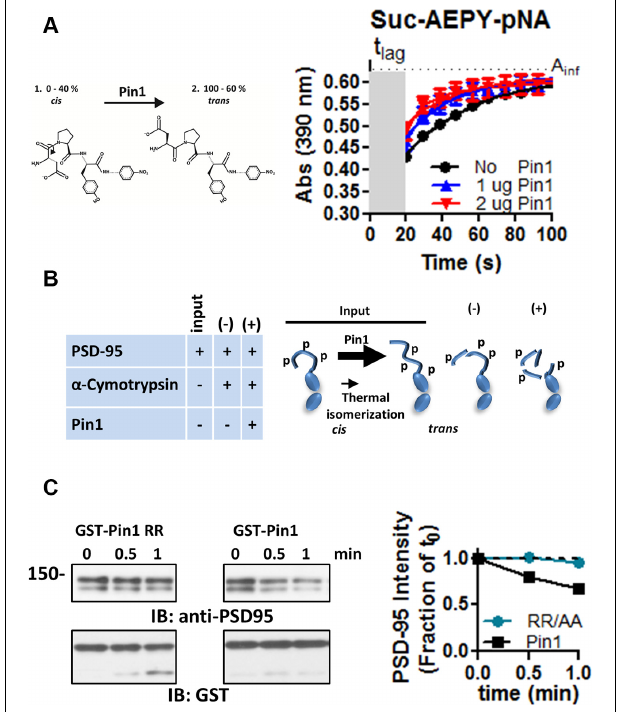
FIGURE 3 | Pin1 isomerizes full-length PSD-95. (A) A cis-trans isomerization scheme mediated by Pin1 on the succinyl-AEPY-p-nitronilide peptide. For representation, only EPY-p-nitronilide is shown. The predicted amounts of each isomer in solution (see “Materials and Methods/References” secton). The cis-trans isomerization assay to test the functionality of the purified GST-Pin1. (B) (Left) Table showing the experiment design for the α -chymotrypsin-coupled cis-trans isomerization assay. (right) Scheme of the Pin1-mediated isomerization reaction, only N-terminus, PDZ1 and PDZ2 are shown. Input condition contains both cis and trans -N-terminus PSD-95, ( − ) PSD-95 product in the presence of α -chymotrypsin alone and (+) PSD-95 product in the presence of Pin1 with α -chymotrypsin. (C) Immunoblot showing the results of the in vitro α -chymotrypsin cis-trans isomerization of full-length PSD-95. Homogenates of COS cells expressing full-length PSD-95::EGFP were incubated with the isomerase dead GST-Pin RR68, 69AA or GST-Pin1 and treated with 0.1 µ g of chymotrypsin. Reactions were subjected to Western immunoblotting with anti-PSD-95 and GST antibodies. (middle) Quantification of immunoblot band intensities normalized to time 0 for the 135 kDa band ( n =